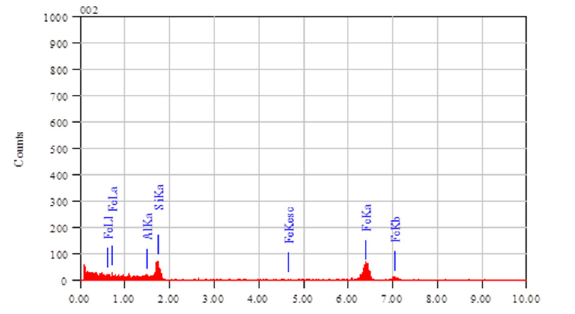
Fig. 14(b): Elemental results of Shikarap Iron Ore before Adsorption